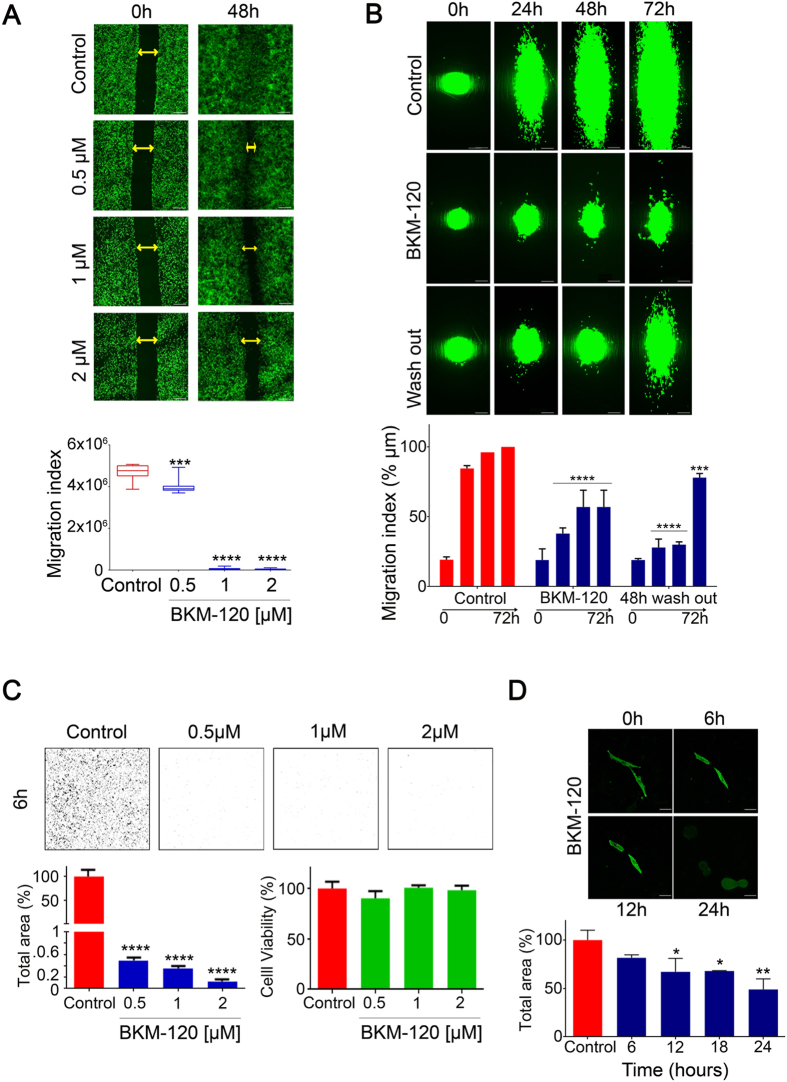
Impact of BKM-120 on GBM cell migration and morphology.(A) Time-lapse images of U251-GFP GBM cells in wound-healing assays performed on U251-copGFP with increasing concentrations of BKM-120 (0.5, 1 and 2 μM) over 48 h. Controls were treated with DMSO. The gap is indicated by double arrows and the migration index was measured as total area of the gap (bar = 100 μm). (B) Time course over 72 hours on nanofiber scaffolds of G9-copGFP GBM cells treated with DMSO or BKM-120 (2 μM). The wash out performed at 48 hours demonstrates recovery of cell migration after drug removal. The lower graph indicates percentage of migration index compared to controls at 72 hours (100%) (bar = 100 μm). (C) Dose-dependent effect of BKM-120 on U251 GBM cells in transwell assays after 6 hours. The images show the ImageJ generated masks used to quantify the cell migration. Cell viability assays were performed on the same cells at the same time point using PrestoBlue. (D) Cell morphology. Time course of U251-copGFP GBM cell shape changes after treatment with 2 μM BKM-120 (bar = 50 μm). The graph indicates the percentage of total area compared to time 0h at 6, 12 and 24 hours (100%) (bar = 100 μm). One-way ANOVA was used for statistical analysis (*p < 0.05, **p < 0.01, ***p < 0.001, ****p < 0.0001).